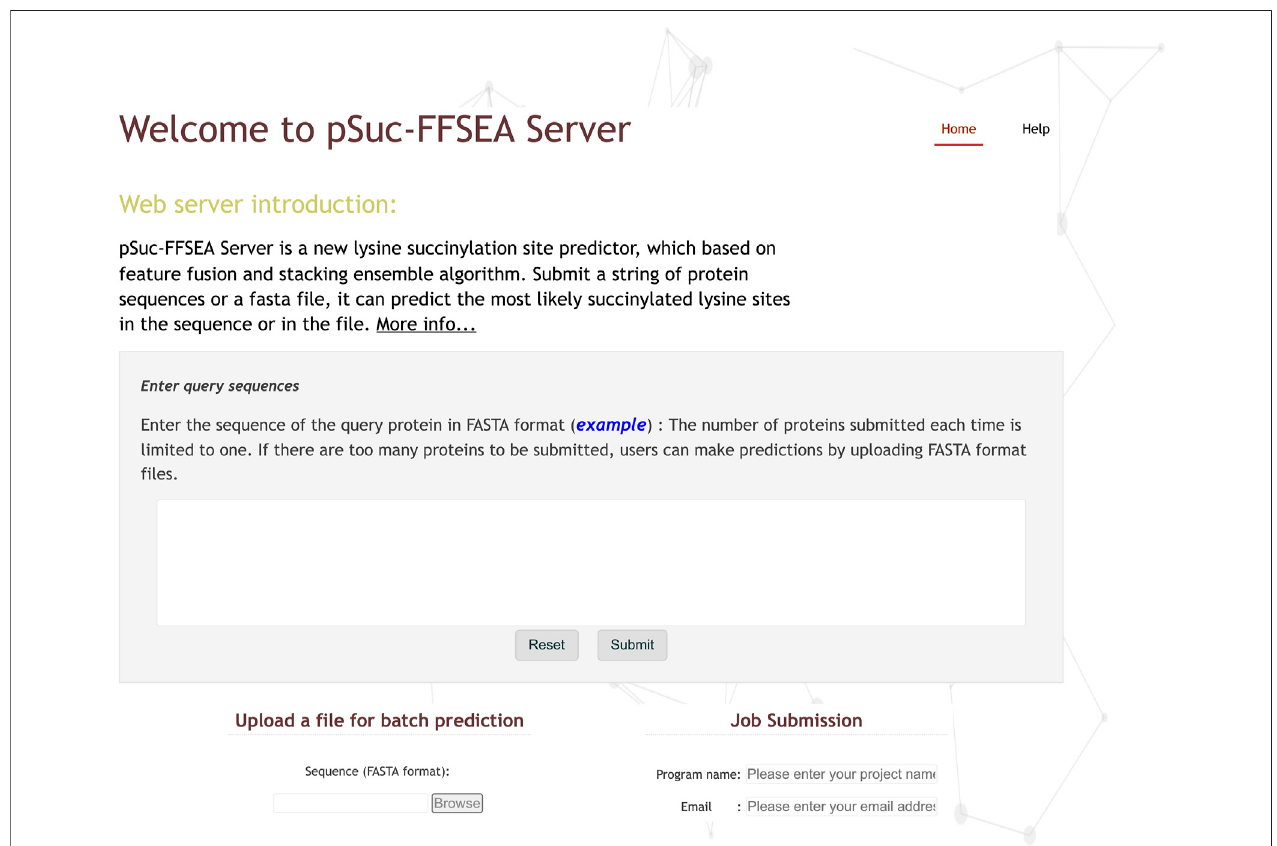
FIGURE 9 | The screenshot to show the homepage of the pSuc-FFSEA web-server at https://bio.cangmang.xyz/pSuc-FFSEA.